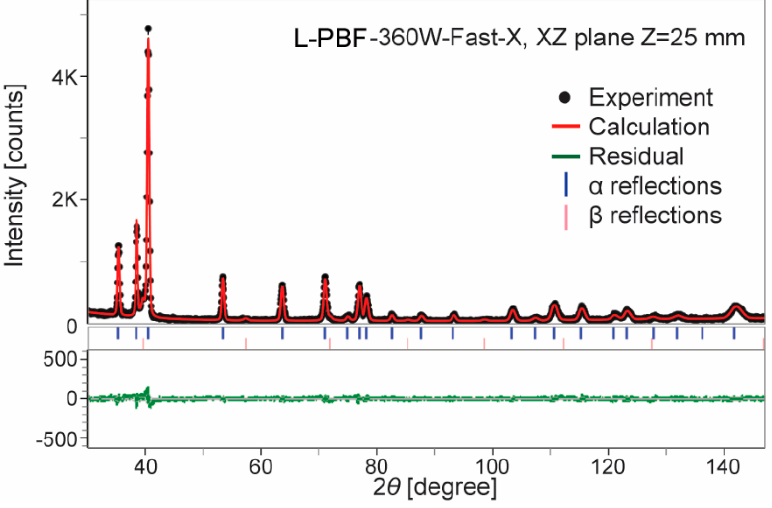
Figure 4. WPF analysis result of L-PBF-360W-Fast-X on the XZ plane at Z = 25 mm. Figures 5–7 show the random lattice strain of α or α ’ phase in the a - and c -axis directions, c / a , and β quantity plotted against the crystallite size of the α or α ’ phase, respectively. All parameters showed a strong correlation with the crystallite size, indicating that as the crystallites of the α or α ’ phase grew, the random lattice strain decreased, and c / a increased. All these structural changes are related to the shift from α ’ to α or α + β structures [9,10]. However, the same crystallite sizes of the α or α ’ phases have different corresponding random lattice strains and c / a of the α or α ’ phases in the L-PBF and EB-PBF parts. Furthermore, in the L-PBF parts, the β phase quantity increased as the crystallites grew, while the β phase was not detected in the EB-PBF-made parts. It is also notable that the random lattice strain in the c -axis direction was smaller than that in the a -axis direction. This result indicates that a greater number of dislocations cause atomic displacement in the a -axis direction [44], which is consistent with the fact that the preferred Burgers vector in (cid:10) (cid:11) the hcp system is 1/3 1120